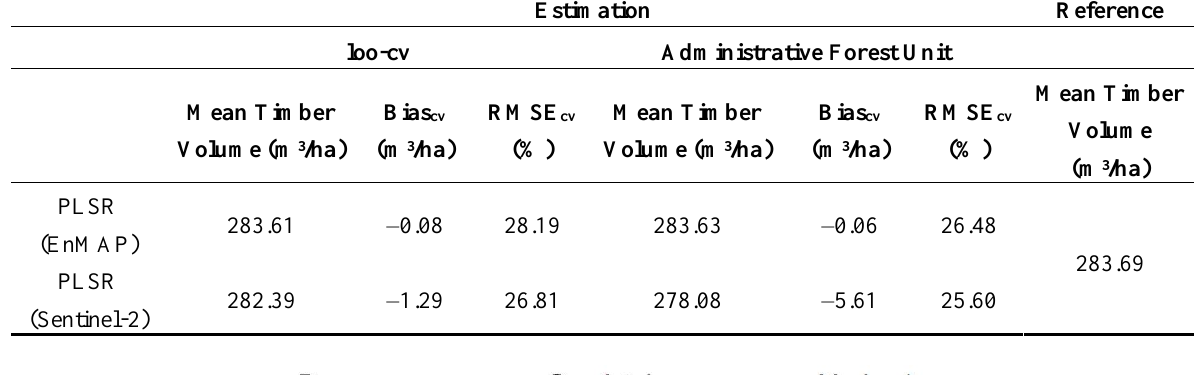
Table 1. RMSE cv , and Bias cv for three PLS-components. Timber volume estimation was based on all available spectral bands. Validation was done using loo-cv (training examples) and on administrative forest units (image-derived maps).